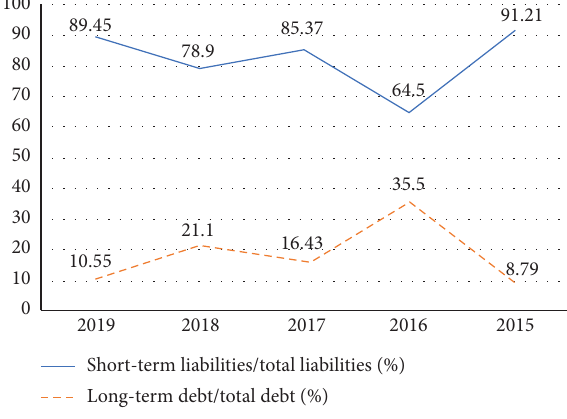
Figure 4: Te debt ratio of a